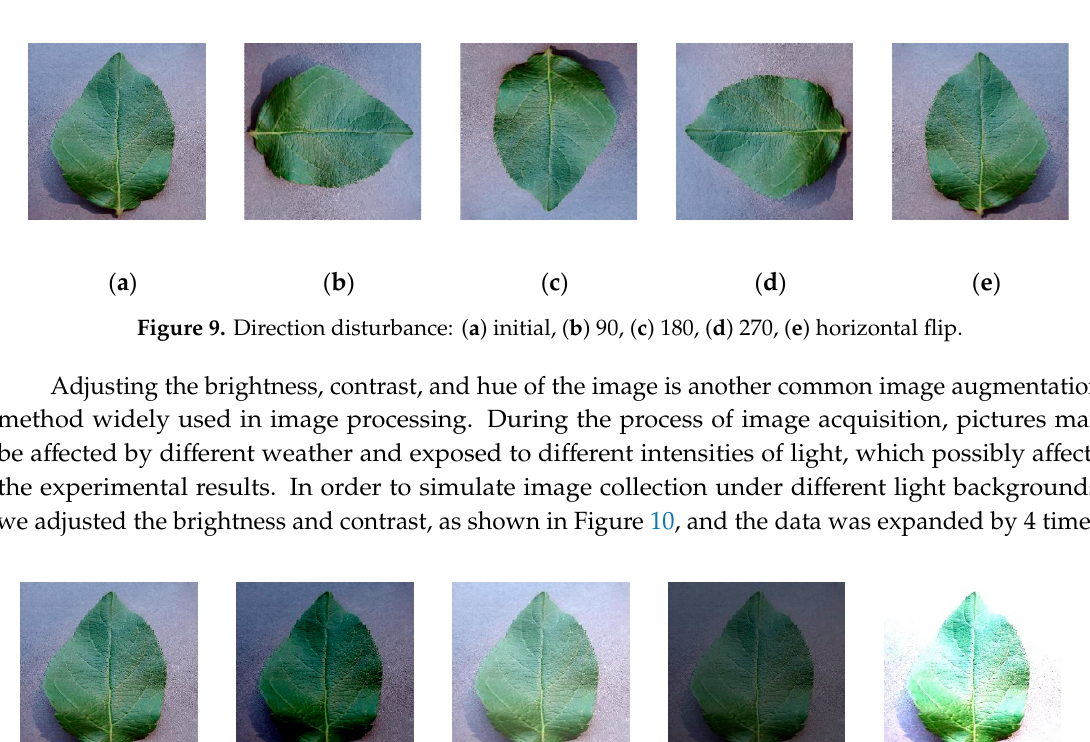
Figure 11. Gaussian noise: ( a ) initial, ( b ) Gaussian noise.